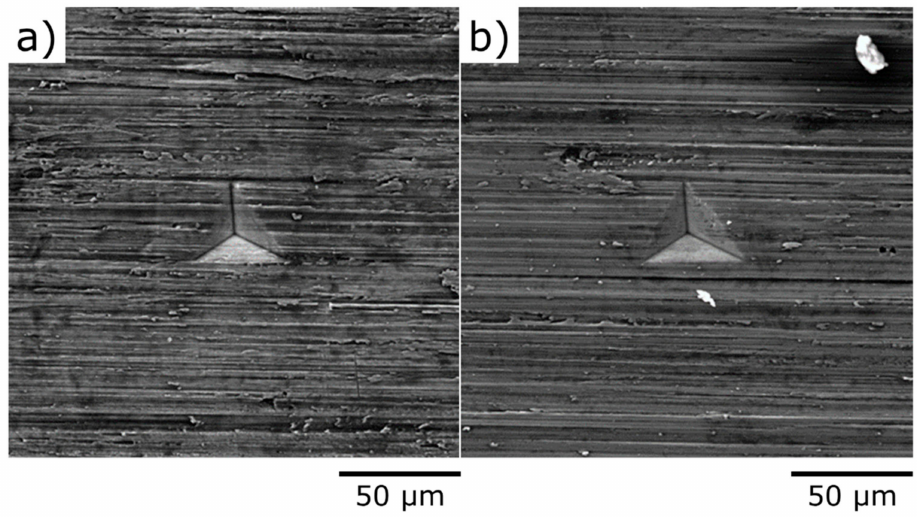
Figure 5. Appearance of VT6 sample surface ( a ) shot peened and ( b )